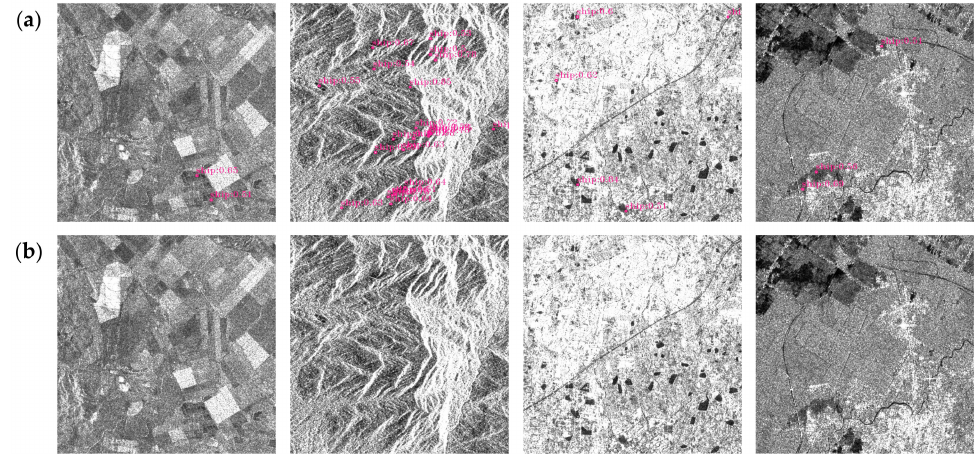
Figure18. SAR ship detection results of faster R-CNN withand without PBHT-mechanism. ( a ) Detection results without PBHT-mechanism; ( b ) detection results with